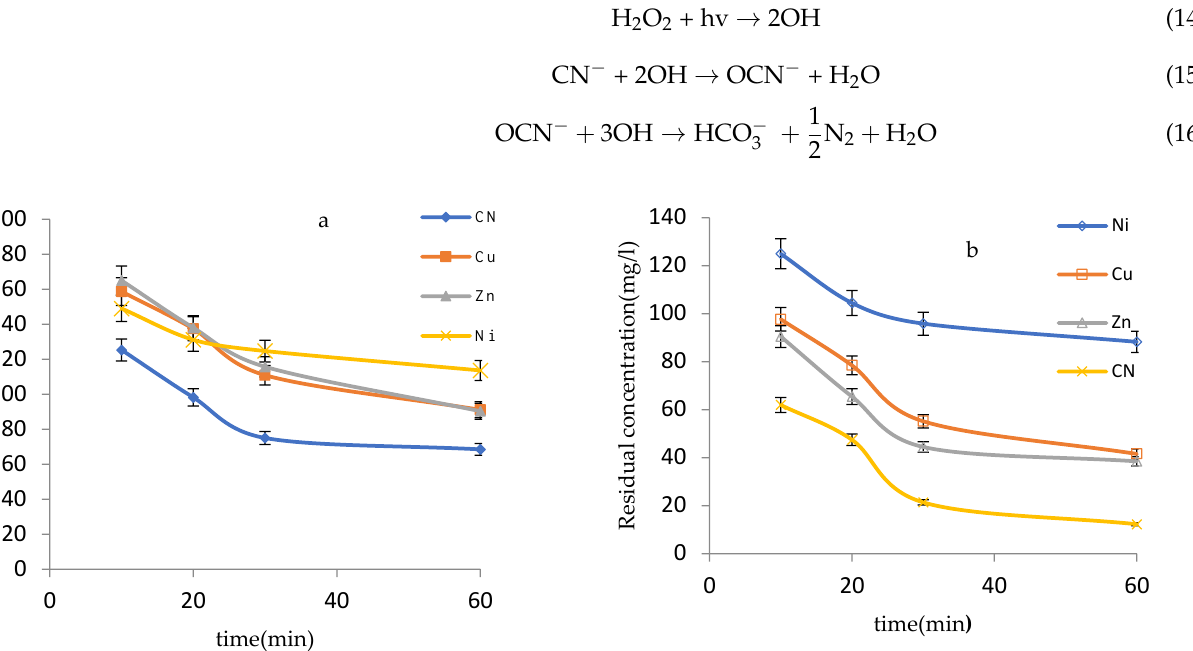
Figure 6. Removal of pollutions using ( a ) LED, ( b ) UVC without EC process. Finally, cyanate is oxidized to bicarbonate and nitrogen